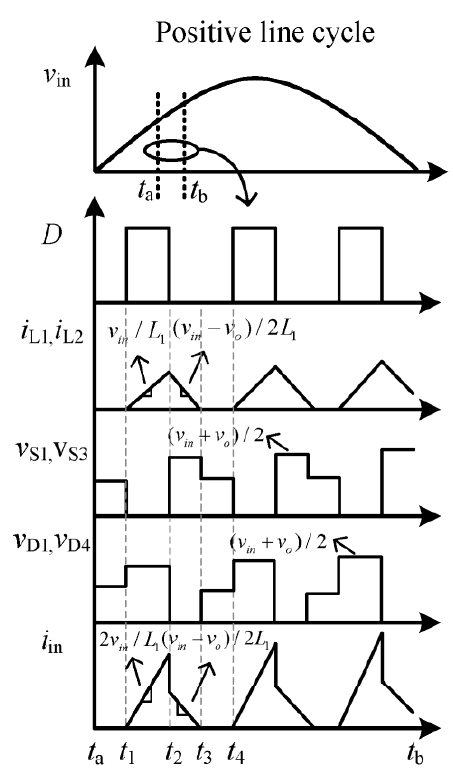
Figure 4. The key time-domain waveforms of the proposed bridgeless high step-up voltage gain PFC converter.